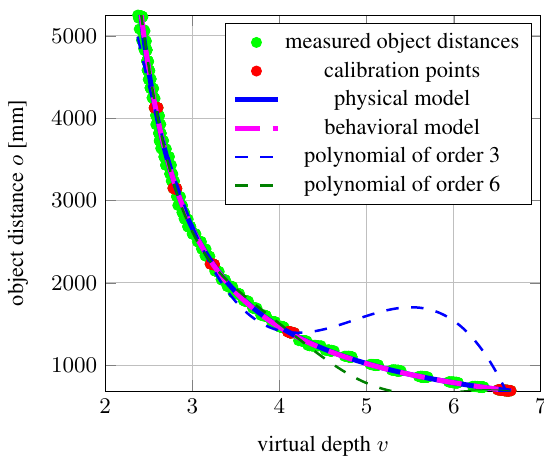
Figure 4: Results of the first experiment for the depth map cal- ibration. Five object distances were used for calibration. The calibration was performed based on the physical model, the be- havioral model and the curve fitting approach.